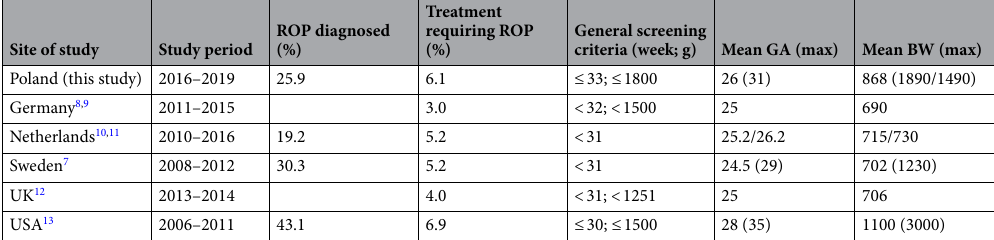
Table 3. The incidence of ROP, screening criteria, gestational age, and birth weight of infants in the present study and the data from Western European countries and the USA.